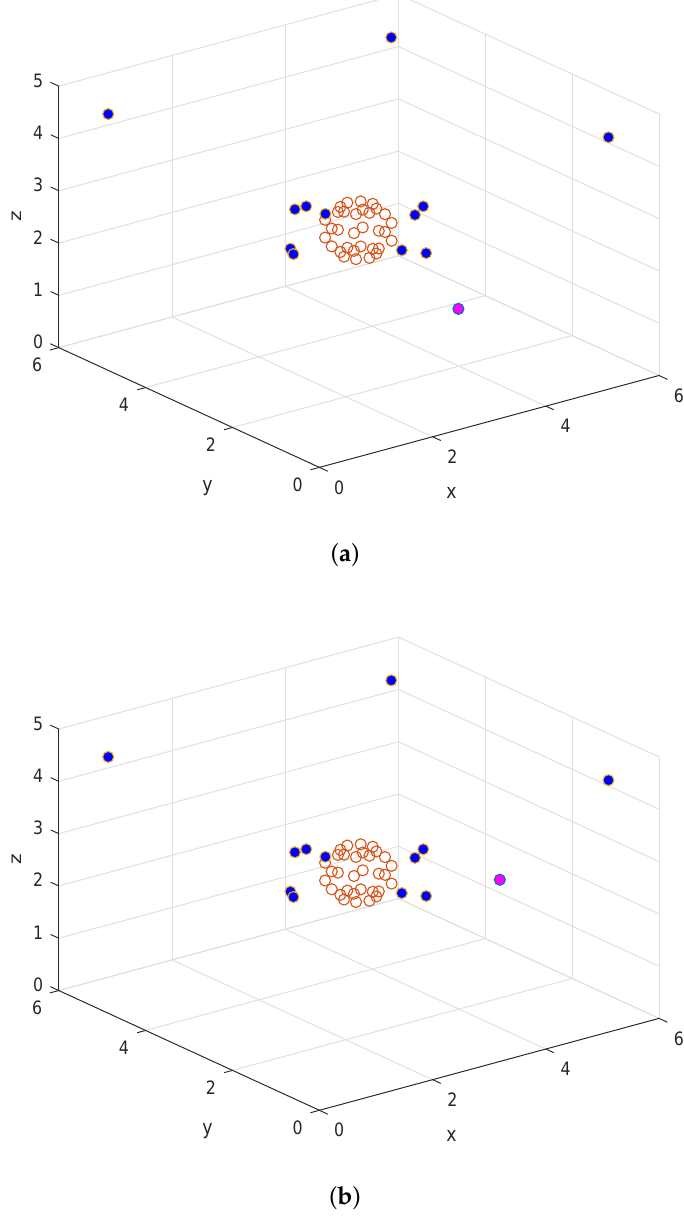
Figure 2. ANC system setup, where the pink point is the noise source position, blue points are loudspeaker positions, and red points are microphone positions: ( a ) case 1; ( b ) case